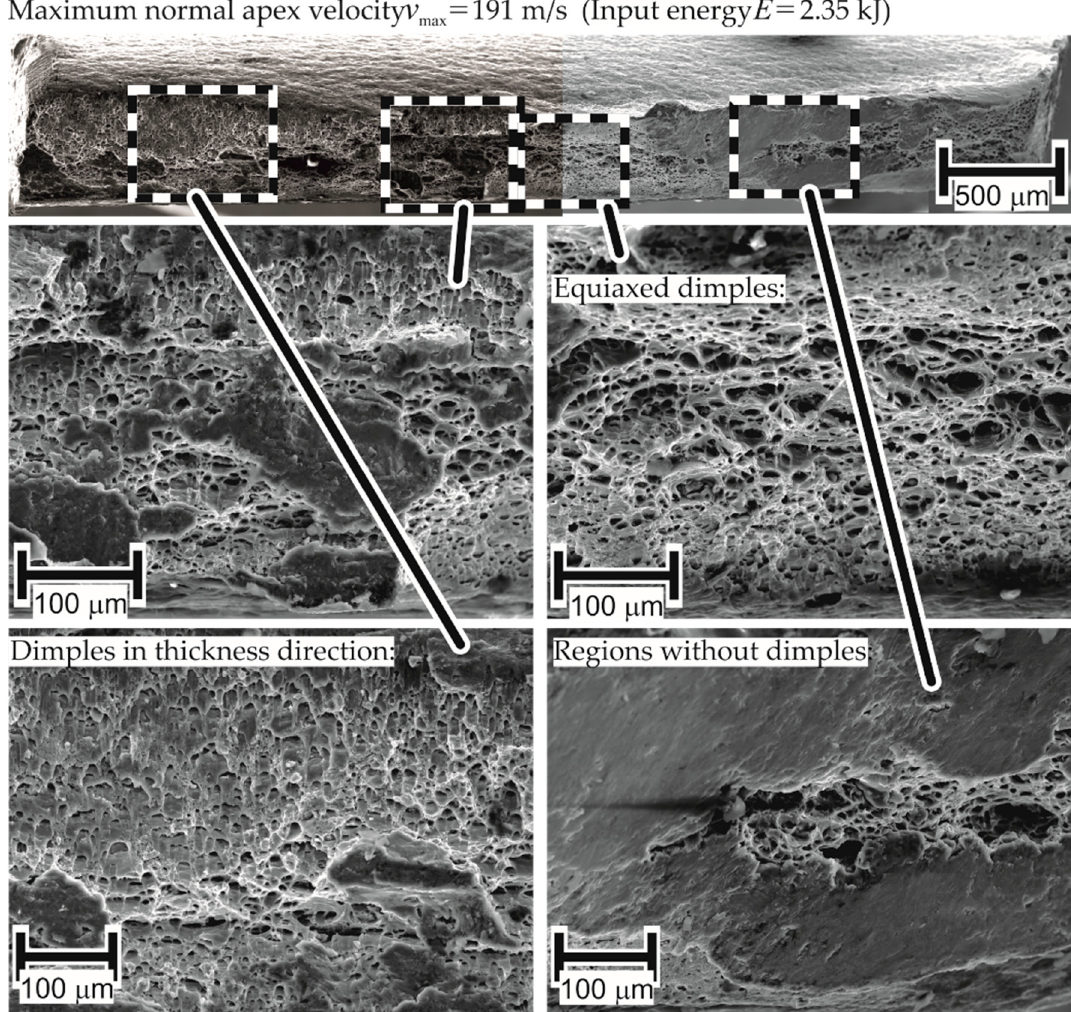
Figure 25. Fracture of electromagnetically formed AA5083-H111 under uniaxial tension (initial thickness 1 mm). 1